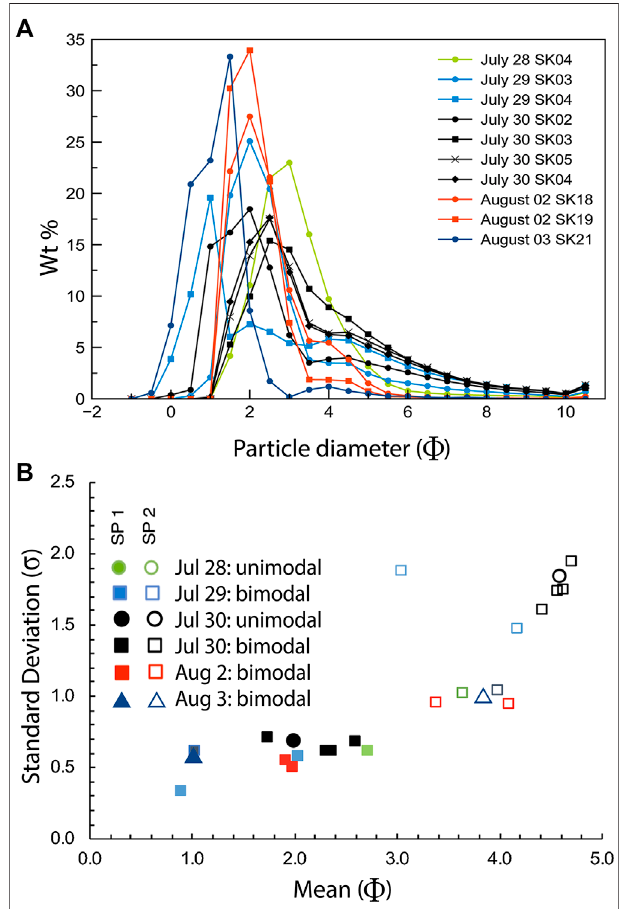
FIGURE 3 | Grain-size of the tephra-fallout samples collected simultaneously with HS-HR videos: (A) Grain-size distributions associated to the different days of video collection (colors); (B) standard deviation ( σ ) and mean ( µ ) of the two Gaussian sub-populations (SP1 and SP2) derived from deconvolution of the grain-size distributions (see Estimate of Aggregate andCoreDensityforfurtherinformation).Inparticular,circlesrefertounimodal GSDs while squares and triangles to bimodal GSDs. Filled and open symbols indicate sub-populations 1 and 2, respectively, and colors refers to the day of